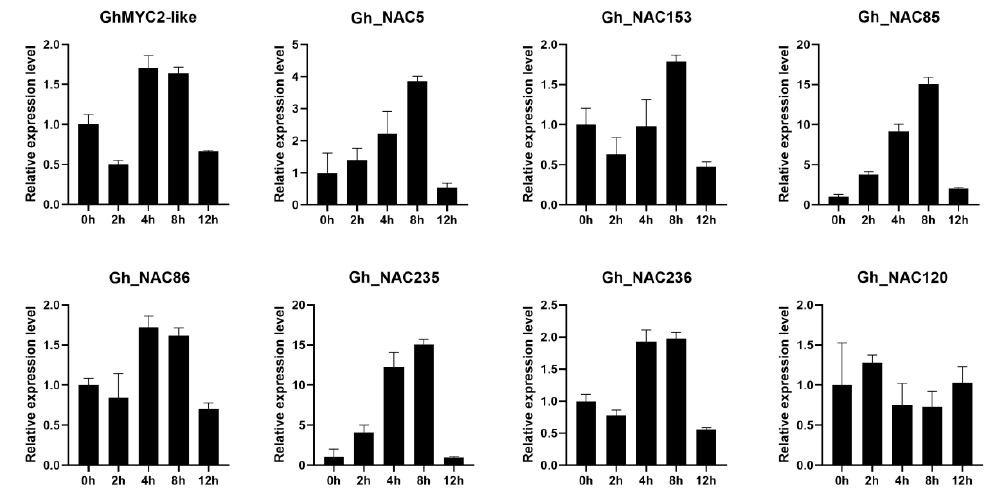
Figure 7. Dynamic expression analysis of GhMYC2-like and 7 NAC genes after MeJA treatment by qRT-PCR (reference gene: actin).